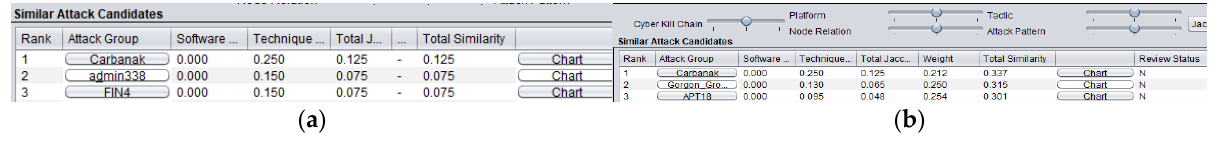
Figure 11. Result of similarity measurement. ( a ) Baseline (Jaccard similarity) and ( b ) baseline + weights.